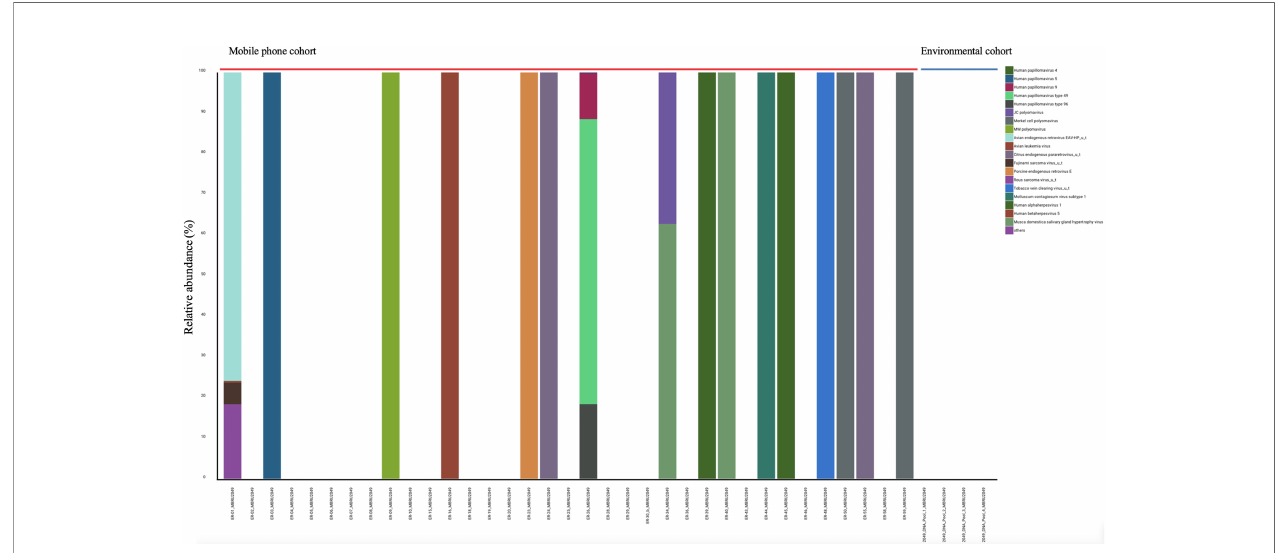
FIGURE 3 | Stacked bar representation of types and relative abundances of viruses found by metagenomic analysis. Mobile phone cohort ( N = 35) and the Environmental cohort ( N =